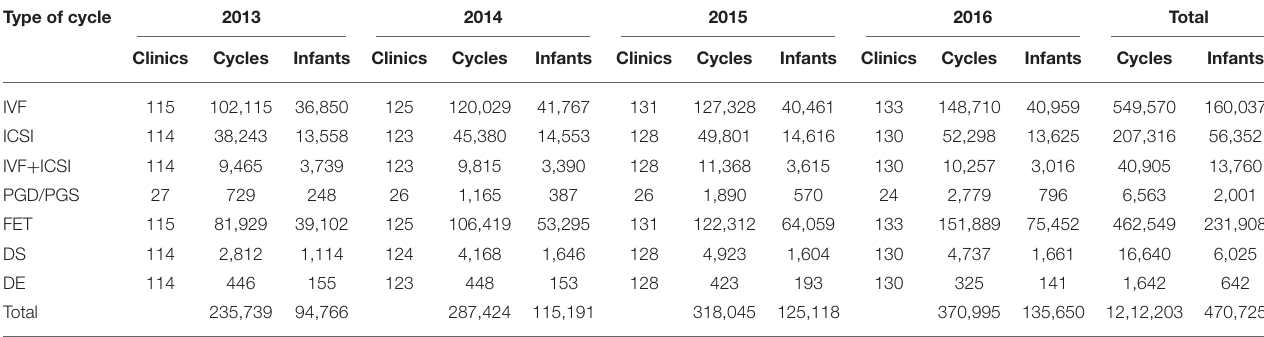
TABLE 1 | Number of clinics, cycles, and ART infants of different technologies in 2013–2016. Type of cycle